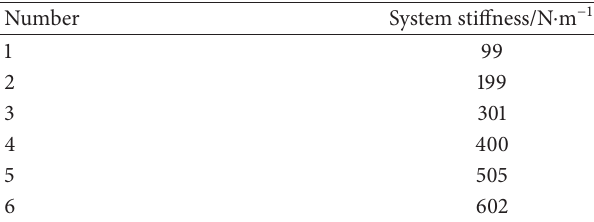
Table 2: The different stiffness